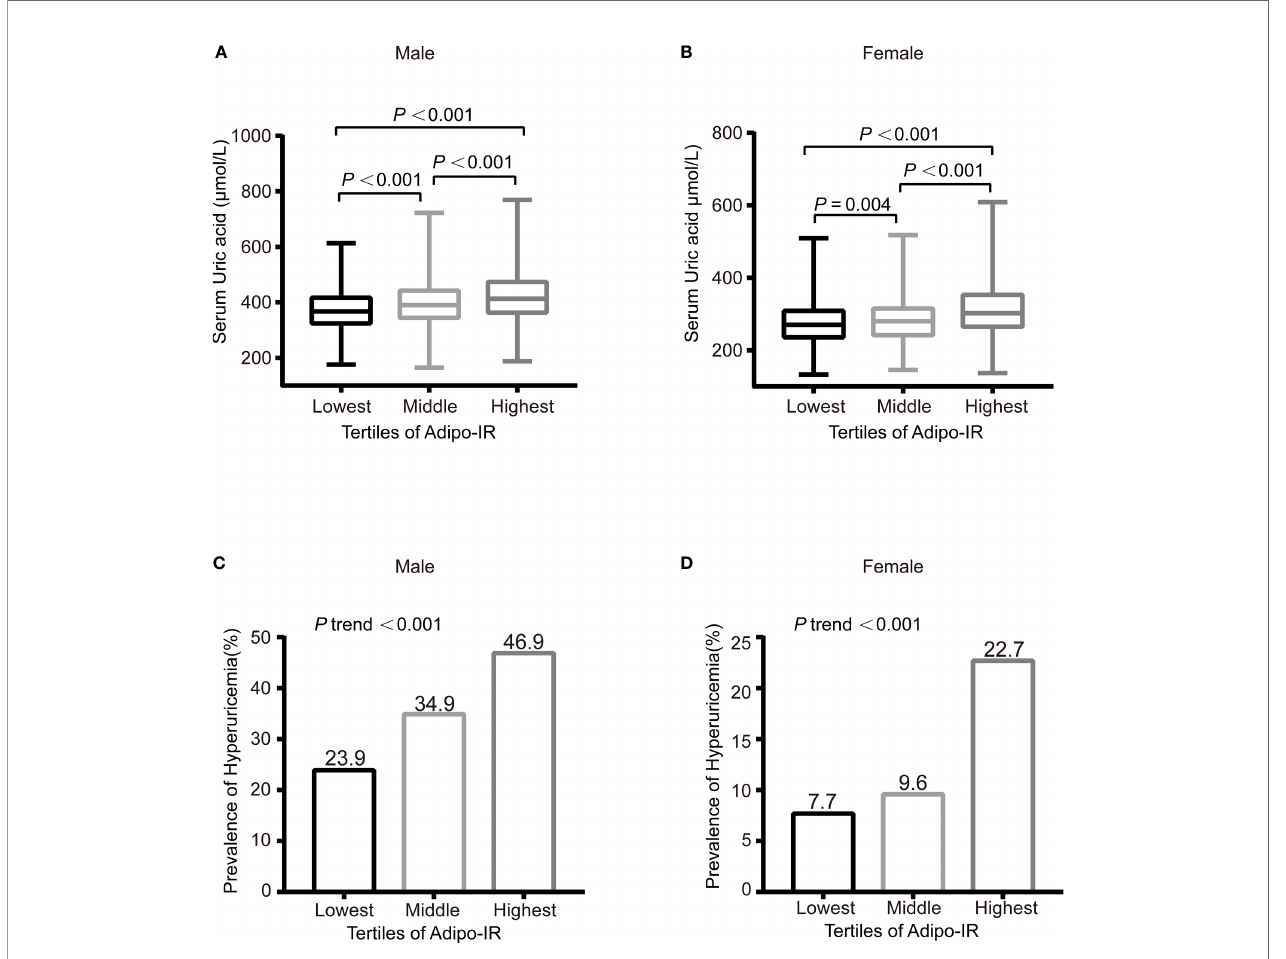
FIGURE 1 | The serum UA levels (A , B) and prevalence of hyperuricemia (C , D) across the Adipo-IR tertiles. Data were expressed as median (upper and lower quartiles) or proportion (%). P trend: from test for linearity.